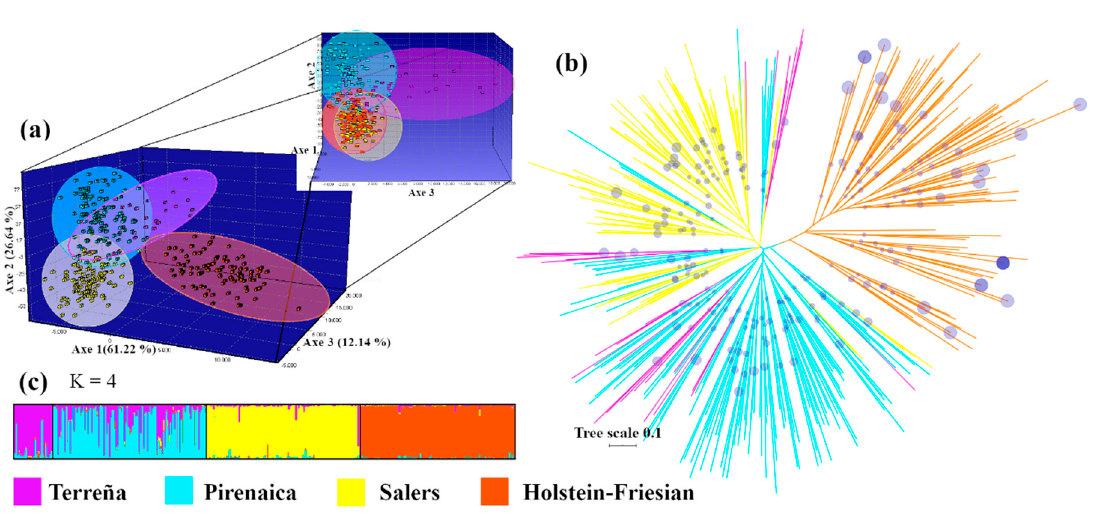
Figure 1. Genetic variations and phylogenetic di ff erentiation analyses among cattle breeds. ( a ) 3D-FCA, ( b ) NJ radiation tree (Scale measured in R ST distance values), size of circles represents bootstraps percentage and ( c ) mean probabilities of individual cluster memberships using structure (K = 4). Table 2. Pairwise F ST (below diagonal) and R ST (above diagonal) between breeds of cattle.